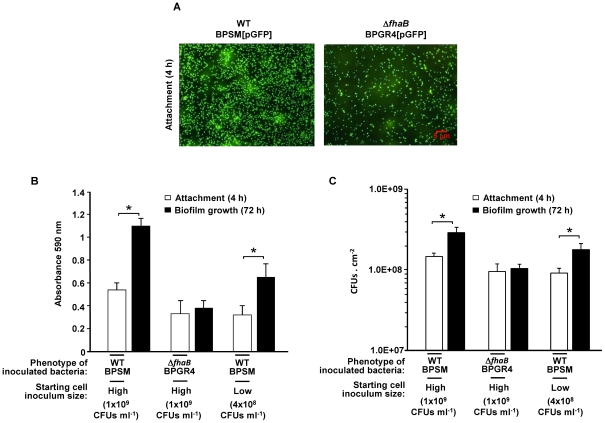
Early attachment of B. pertussis strains to abiotic surfaces.(A) Attachment of WT and ΔfhaB strains to glass. Inoculated bacteria (1×109 CFUs ml−1) were allowed to attach to the surface under static conditions for 4 h at 37°C. Fluorescence images of WT and ΔfhaB GFP-tagged cells that remained adhered to the glass coverslips. (B) Attachment and subsequent biofilm growth by the WT and ΔfhaB B. pertussis strains. WT and ΔfhaB biofilm cultures were initiated with high inoculum levels (1×109 CFUs ml−1). Bacteria were allowed to attach for 4 h followed by incubation under normal biofilm culture conditions. The effect of low-level attachment on subsequent biofilm formation by the WT B. pertussis strain was also examined. The number of WT bacteria in the inoculum was reduced from 1×109 to 4×108 CFUs ml−1 so as to decrease the population of cells initially adhered to the level displayed by the ΔfhaB strain with a high inoculum (1×109 CFUs ml−1), and then incubated under normal biofilm culture conditions. Adhered biomass was stained with CV 0.1% (v v−1). The CV stain associated with cells was solubilized in ethanol/acetone (80∶20) and the resulting solution was subjected to measurement of the absorbance at 590 nm. The data are the means ± standard deviations of three independent experiments. An asterisk indicates significant differences between attachment and biofilm growth (P value <0.05; Student's t-test). (C) Viable cell counts of the adhered cells of each strain to polypropylene beads under the conditions described in B. The adhered cells were gently washed and detached from the polypropylene beads by slight agitation in PBS buffer. Serial dilutions of cell suspensions were then plated on BGA plates. Results are expressed as the number of colony-forming units per unit area (CFUs cm−2). The data are the means ± standard deviations of three independent experiments. An asterisk indicates significant differences between attachment and biofilm growth (P value <0.05; Student's t-test).